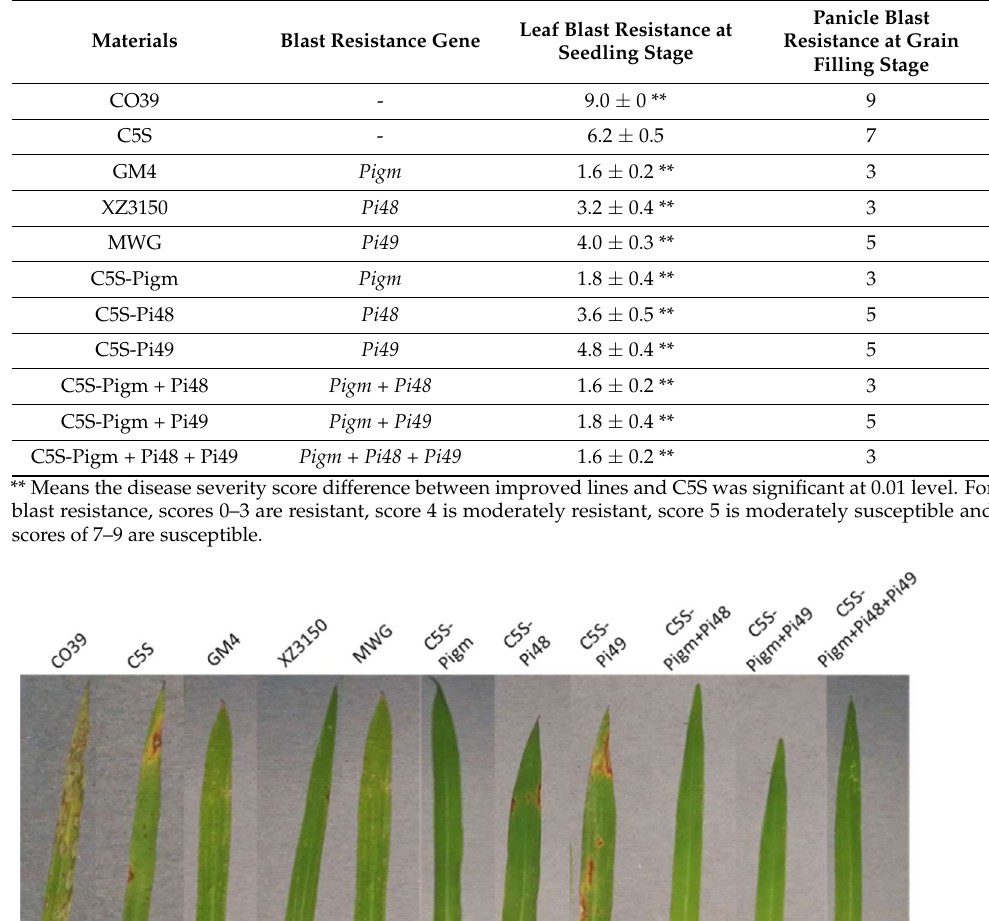
Figure 3. Panicle blast resistance of C5S and the improved lines at grain filling stage. 3.3. Genetic Background Examination of the Pyramided Lines In this study, a 10K whole-genome SNP array was used to analyze the genetic back- ground of the gene pyramided lines. The genetic background recovery rates of the im- proved lines 19RS00207 ( Pigm ) and 19RS00209 ( Pi49 ) were 97.26% and 94.34%, respec- tively. The genetic background recovery rate of the digenic line 19RS00451 ( Pigm + Pi49 ) was 97.53%. The genetic background recovery rate of the trigenic line 19RS00625 ( Pigm + Pi48 + Pi49 ) was 92.68%. Fragments carrying target genes were substituted in the positions (red dots) of Pigm in chromosome 6, Pi48 in chromosome 12 and Pi49 in chromosome 11, indicating the successful introgression of blast resistance genes (Figure 4).